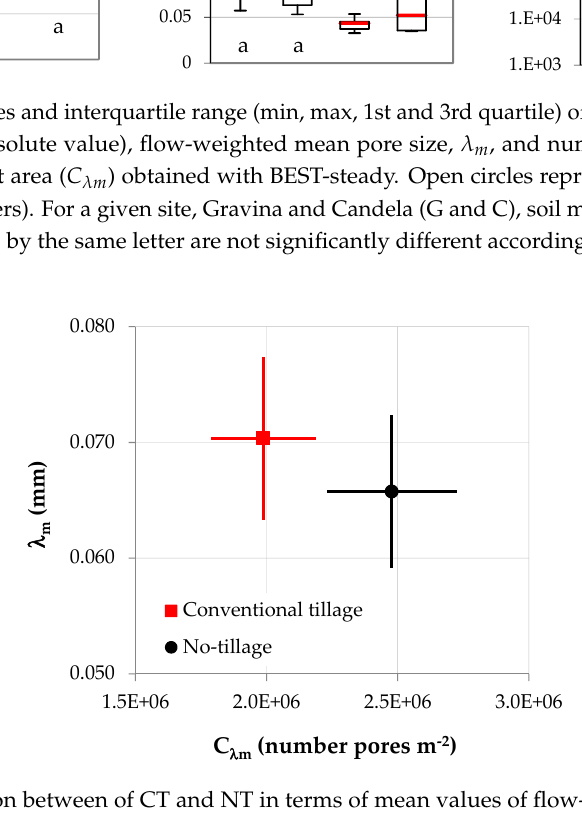
Figure 6. Hydraulic conductivity functions obtained with BEST-steady at Gravina ( a ) and Candela ( b ) sites. The comparison between CT and NT based on measured soil water retention is depicted in Figure 7. In general, measured soil water retention data showed a relatively low variability as coefficients of variation (CVs) of θ values ranged from about 15–20% to 2–3%, decreasing as the potential decreases (i.e., − 5 to − 15300 cm). As shown, noticeable differences in soil water retention were detected only in the Candela site, as relatively low differences were detected between CT and NT in Gravina only close to water saturation (e.g., 0.06 cm 3 cm − 3 at h = − 5 cm) (Figure 7). In other words, the water retention curve of Candela-CT highlighted the typical features of a tilled soil, namely: (i) relatively lower bulk density value, and (ii) relatively low value of the pressure head at the inflection point (i.e., 10 cm against 25–26 cm for the remaining ones). This behavior is adequately